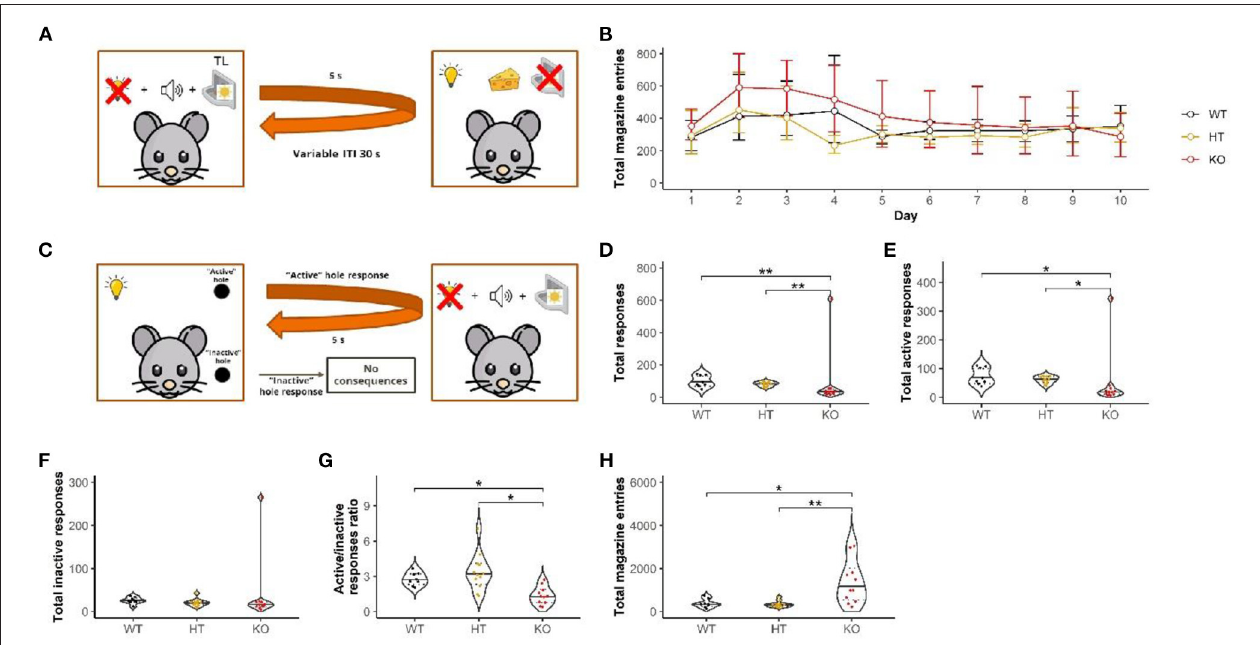
FIGURE 3 | Acquisition of new response reinforced by CS was disrupted in the DAT-KO rats. Although throughout the first stage (A) conditioning was unaffected (B) , during the test (C) active hole preference was lower for DAT-KO rats (G) without difference in responding in the “inactive” hole (F) . Data are represented as mean ± 95% confidence interval (B) and violin plots with median (solid line) and 25th and 75th percentiles (dotted lines) and points indicating each value (D–H) . TL, tray light; * p < 0.05, *** p < 0.001, Dunn’s